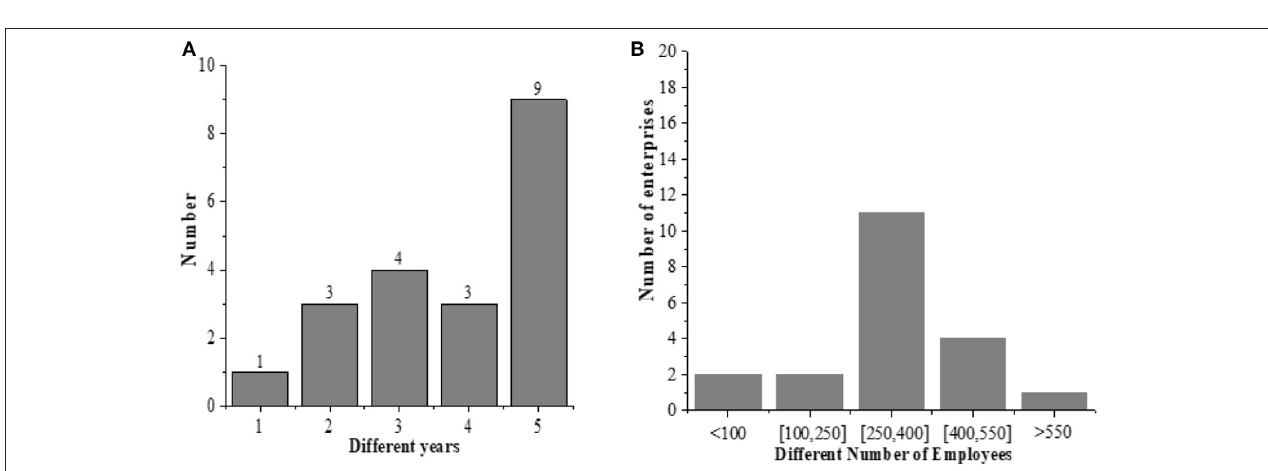
Among the subjects, there are 191 male entrepreneurs and 109 female entrepreneurs, and the proportion of male-female is not balanced. Thus, different innovative strategies should be employed according to the gender ratio of new